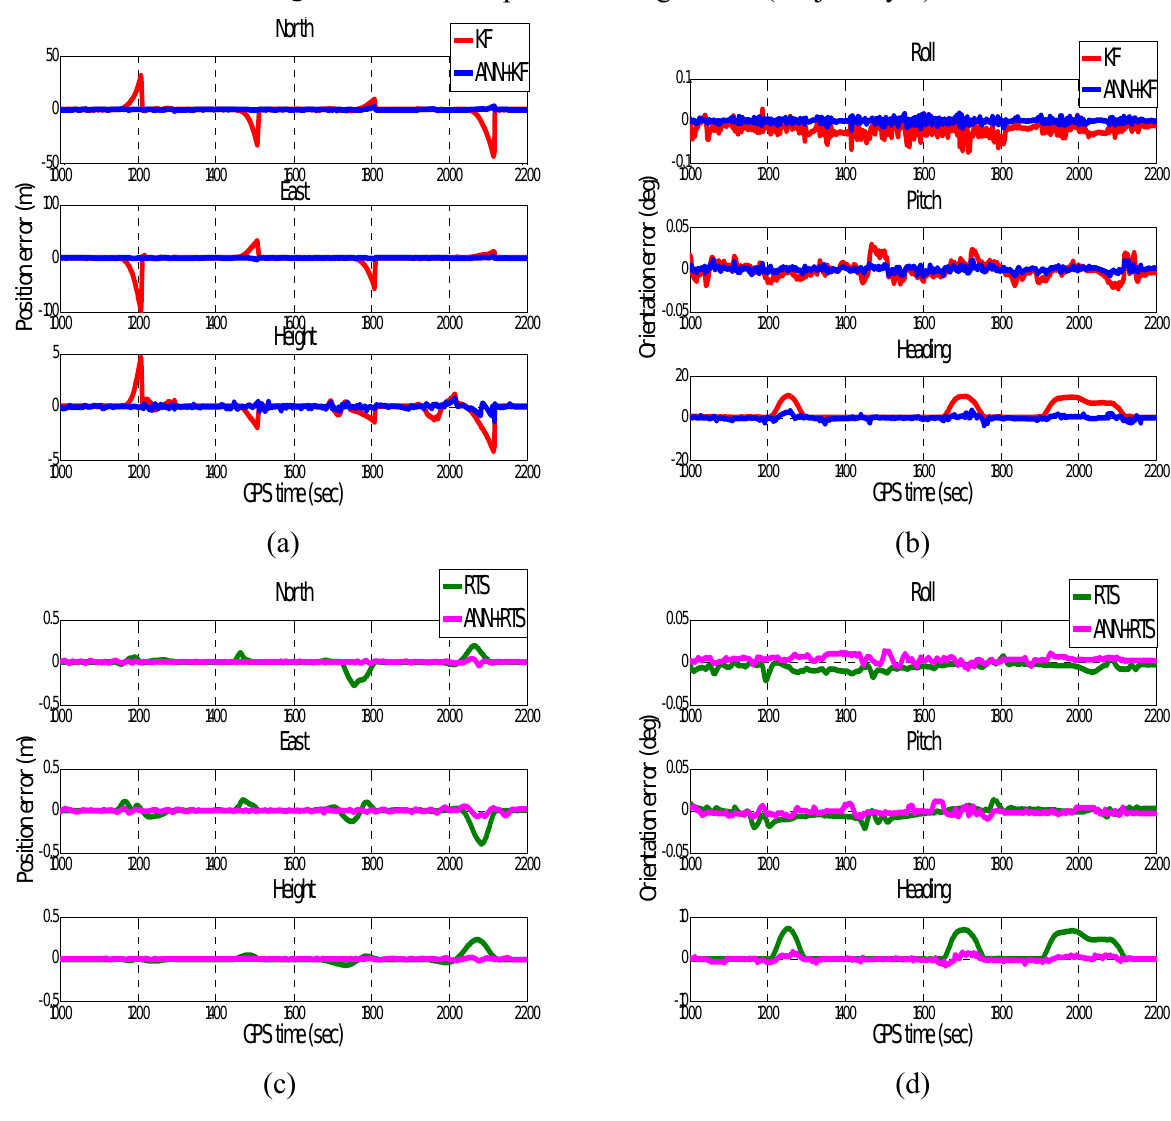
Figure 15. The samples of testing results (Trajectory